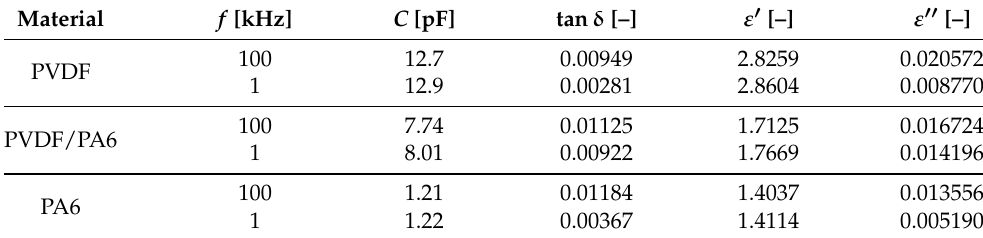
Table 6. Dielectric properties of materials at 1 and